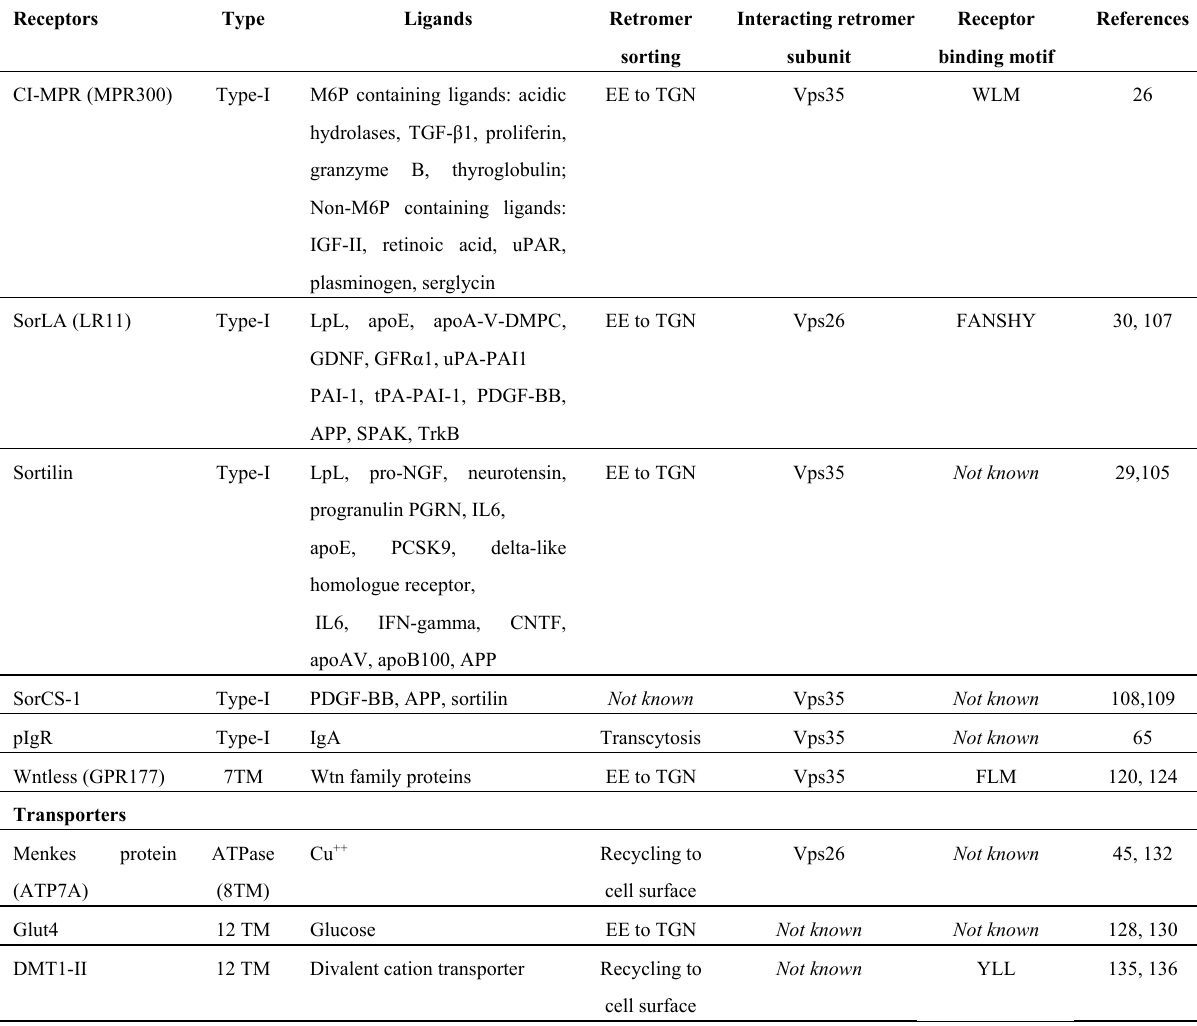
Table 1. Receptors and transporters engaging in retromer-mediated